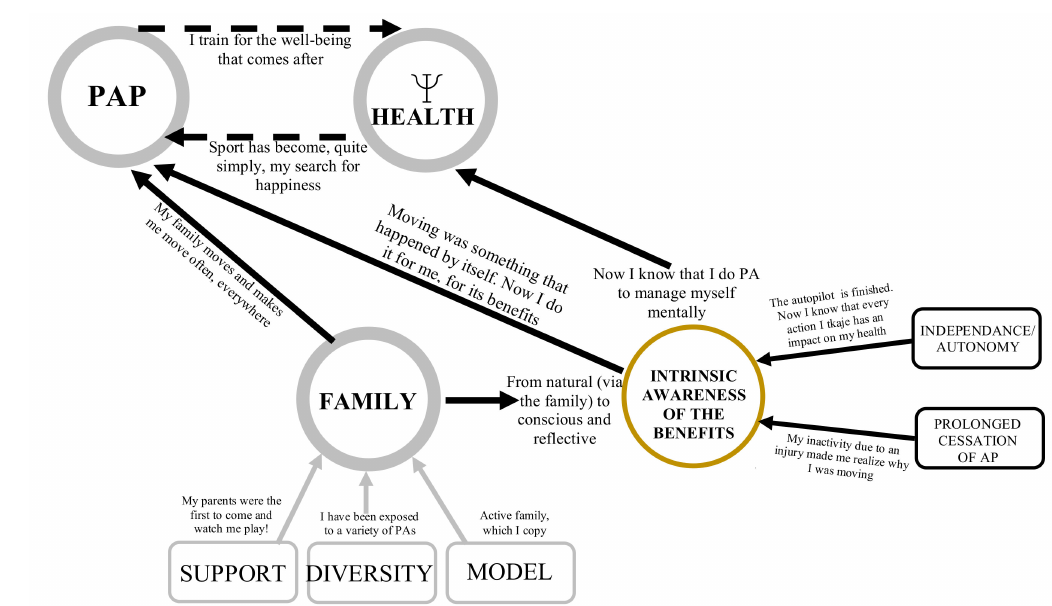
Figure 4. Intrinsic awareness of the benefits of physical activity as a driver for adoption and maintenance of healthy lifestyle habits.